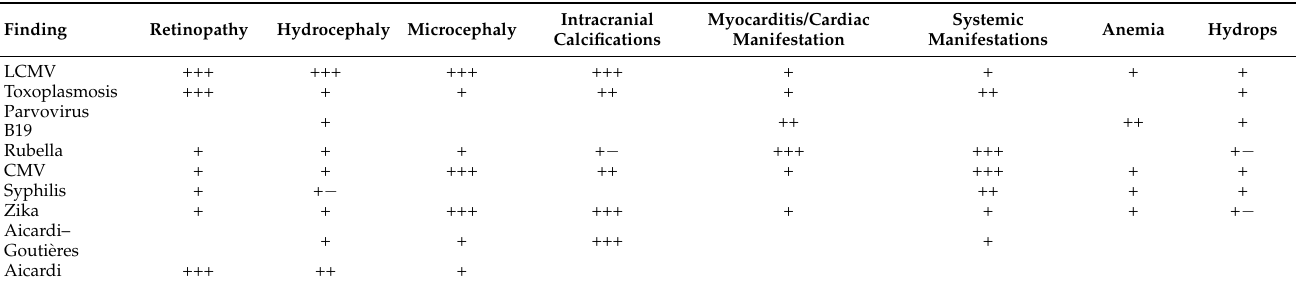
Table 2. Differential diagnoses of LCMV